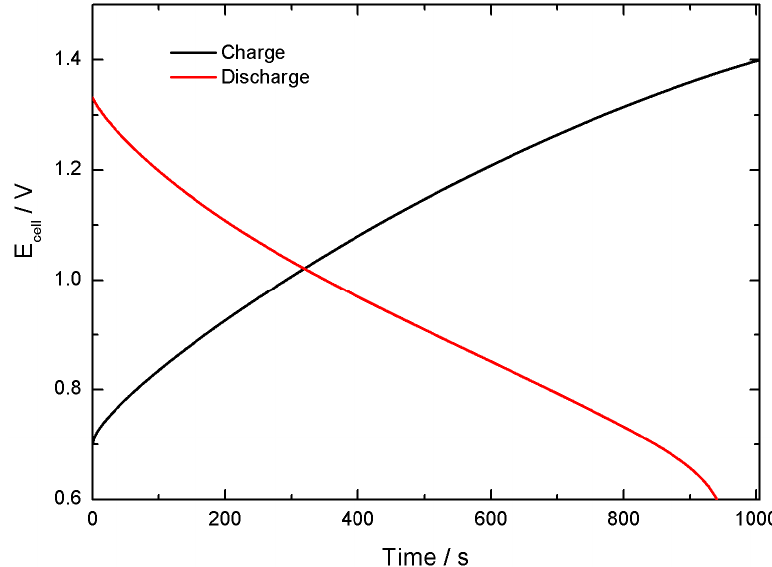
Figure 16. Galvanostatic charge and discharge curves at 1 mA cm − 2 in the 0.6 V to 1.4 V range for the coin cell.